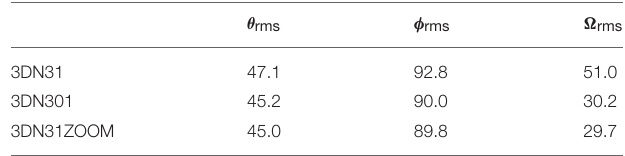
TABLE 2 | Optimization results for a likelihood function with a single